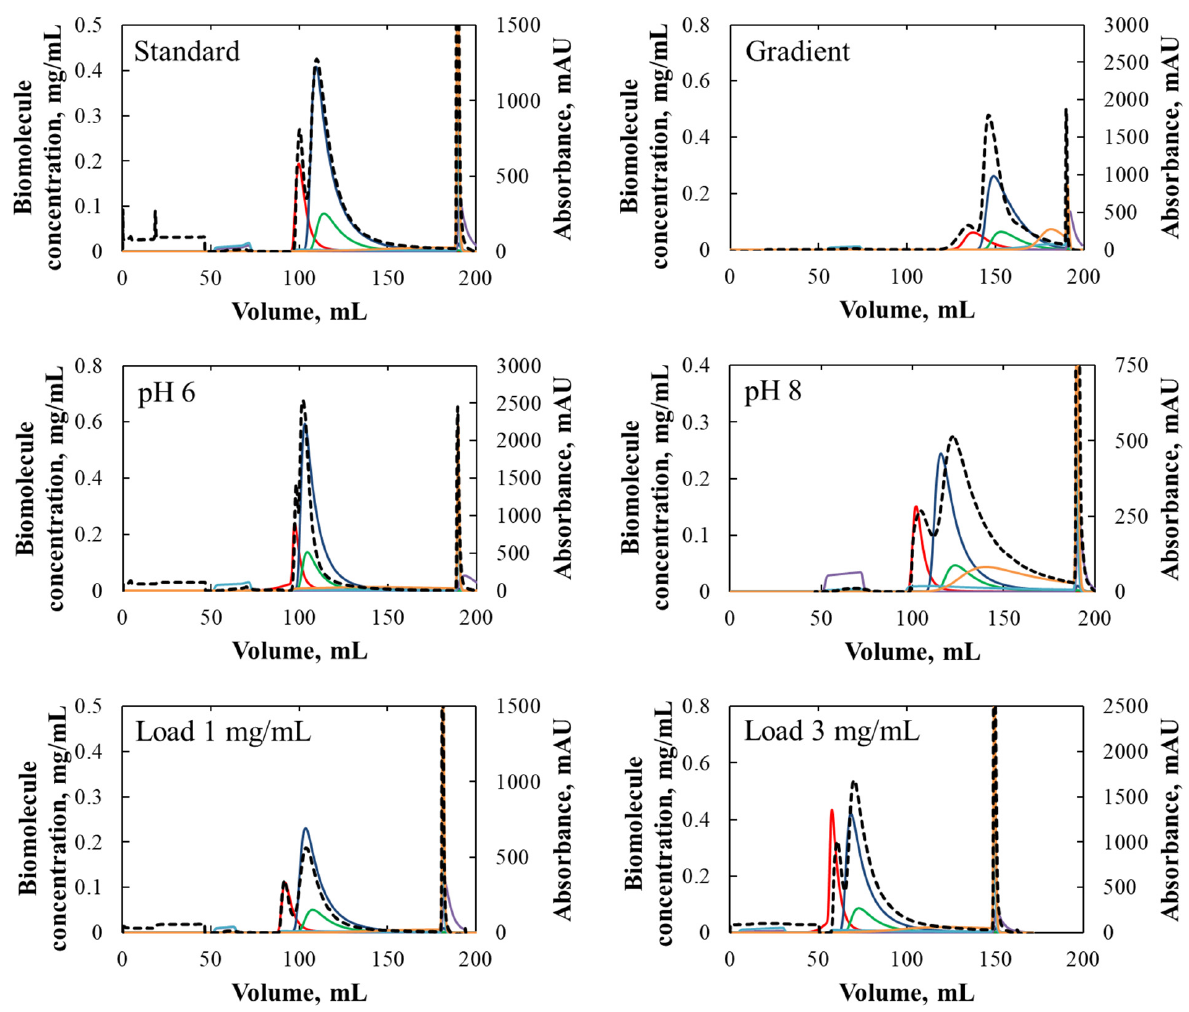
Figure 11. Chromatograms obtained from DSPX modeling: the black dashed line refers to the experimental absorbance. The red line is the Monomer 1 concentration, the dark blue line is the Monomer 2a concentration, the green line refers to Monomer 2b concentration and the violet line to Monomer 3 concentration. Light blue and yellow lines refer to LMWC and HMWC concentration, respectively.